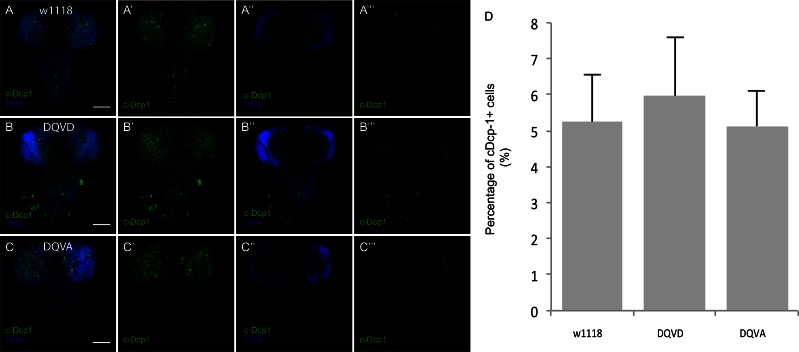
Caspase activity during larval CNS development.(A,B,C) Anti-cleaved Dcp1 antibody staining (green) detects caspase activity during larval brain development in w1118 (A) CasExpress DQVD (B) and DQVA control (C). (A–C) (A'–C') are Z-projection of images generated by maximum intensity algorithm, (A''–C'') (A'''–C''') are single slices of each image. (A'–C') (A'''–C''') are cleaved Dcp1 only. (D) Quantification of the percentage of cDcp-1-expressing cells. Scale bars are 100μm.